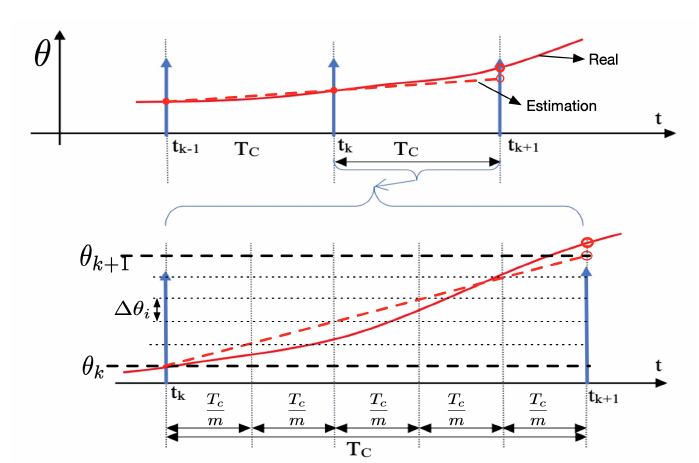
Figure 3. Discrete time interval sub-division